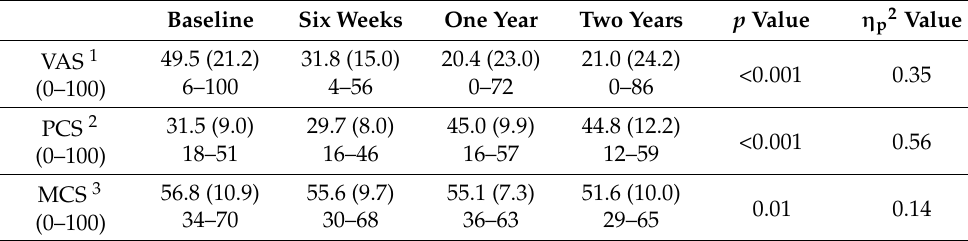
Table 2. Baseline and follow-up results of pain intensity and health-related quality of life outcomes of the patients ( n = 25). Values presented as mean (SD, minimum and maximum).